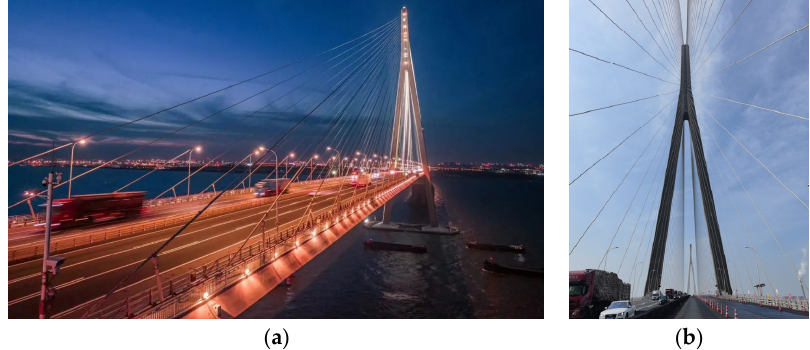
Figure 12. Sutong Highway Bridge: ( a ) integrated graph, ( b ) tower and cable. Figure 11. Fatigue cracking of the diaphragm cutouts in orthotropic steel bridge decks.